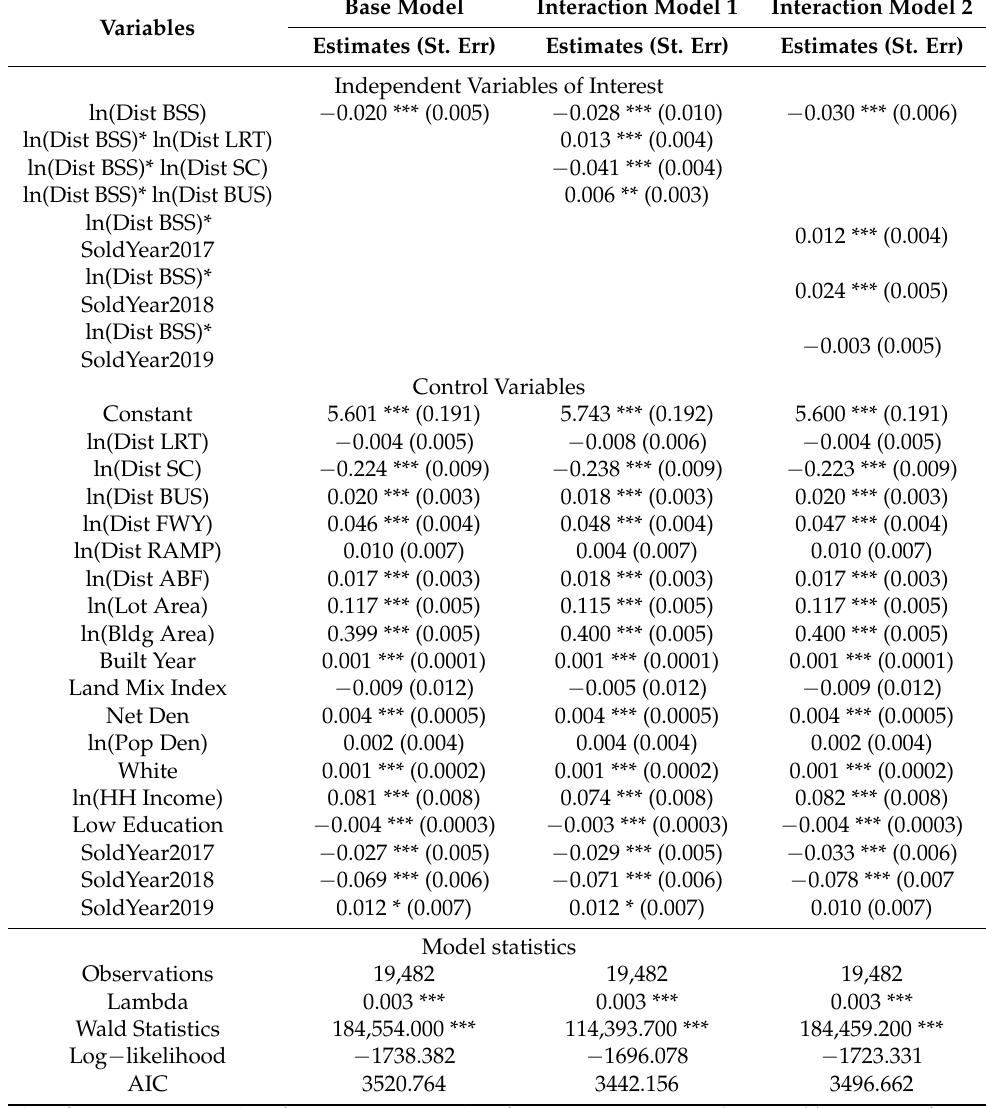
Table 5. Results of spatial error models in the single-family housing